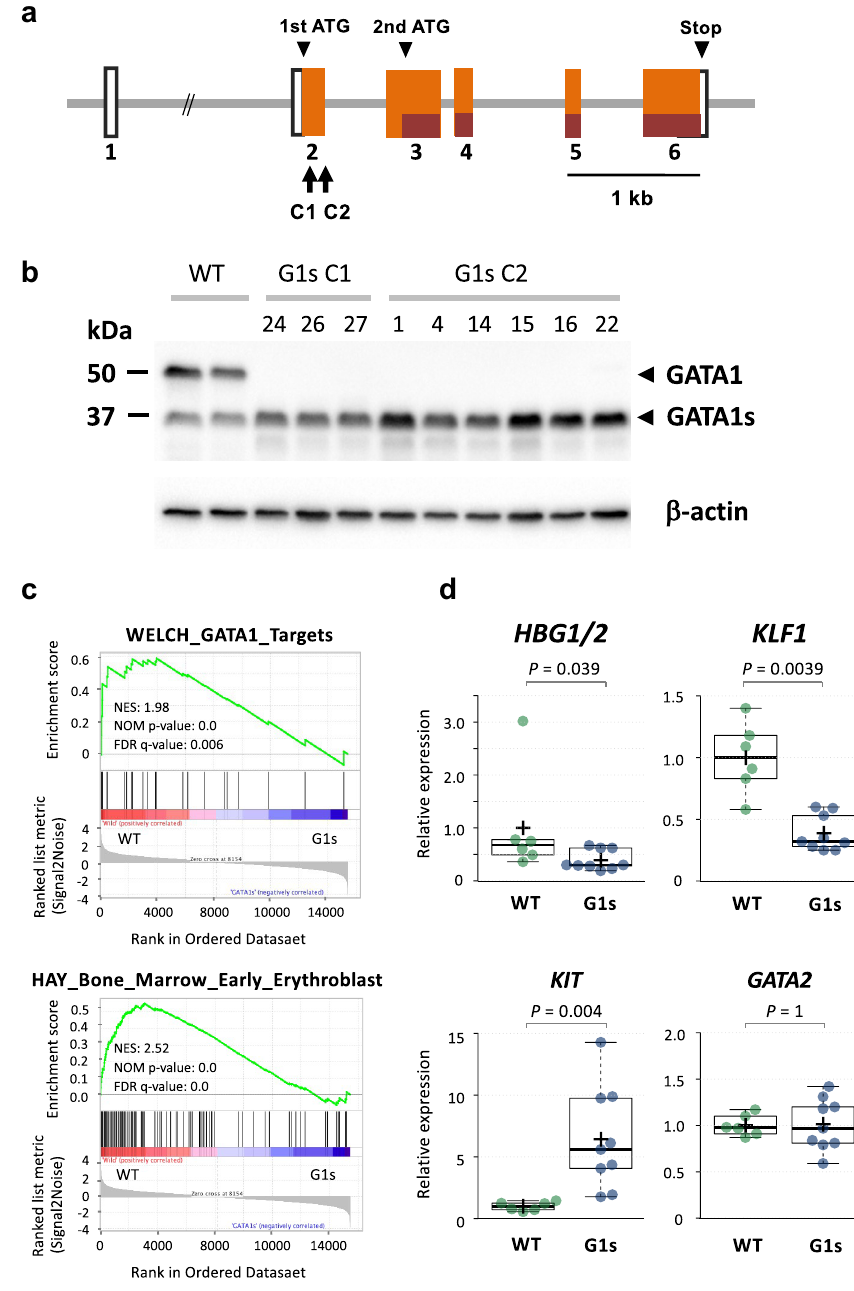
Figure 1. Overview of genome editing of GATA1 gene by CRISPR/Cas9 system. ( a ) Gene structure diagram of G ATA1 . The arrows on C1 and C2 indicate the target positions of the two guide RNAs. ( b ) Detection of GATA1 protein in K562-G1s clones obtained by GATA1 genome editing. Western blotting was performed with anti-GATA1 antibody (D24E4, Cell signaling technology), which could detect both full length GATA1 (45 kDa) and GATA1s (37 kDa) and monoclonal antibody against β-actin (Sigma-Aldrich). Images were obtained using ChemiDoc MP (Bio-Rad Laboratories). Mutations in all clones caused loss of full-length GATA1 production but allowed expression of GATA1s protein from the second translation initiation codon. ( c ) GSEA for the gene sets with differential expression between K562-WT cells and K562-G1s clones. NES, normalized enrichment score; NOM, nominal; FDR, false discovery rate. ( d ) Expression levels of four representative GATA1 target genes in six K562-WT single clones and nine K562-G1s clones by qRT-PCR. Data points were added with dots, and sample means were indicated by crosses. The expression levels of each gene are shown relative to the mean values of the K562-WT single clones, which is set at 1. The P -values of the Mann–Whitney U test were